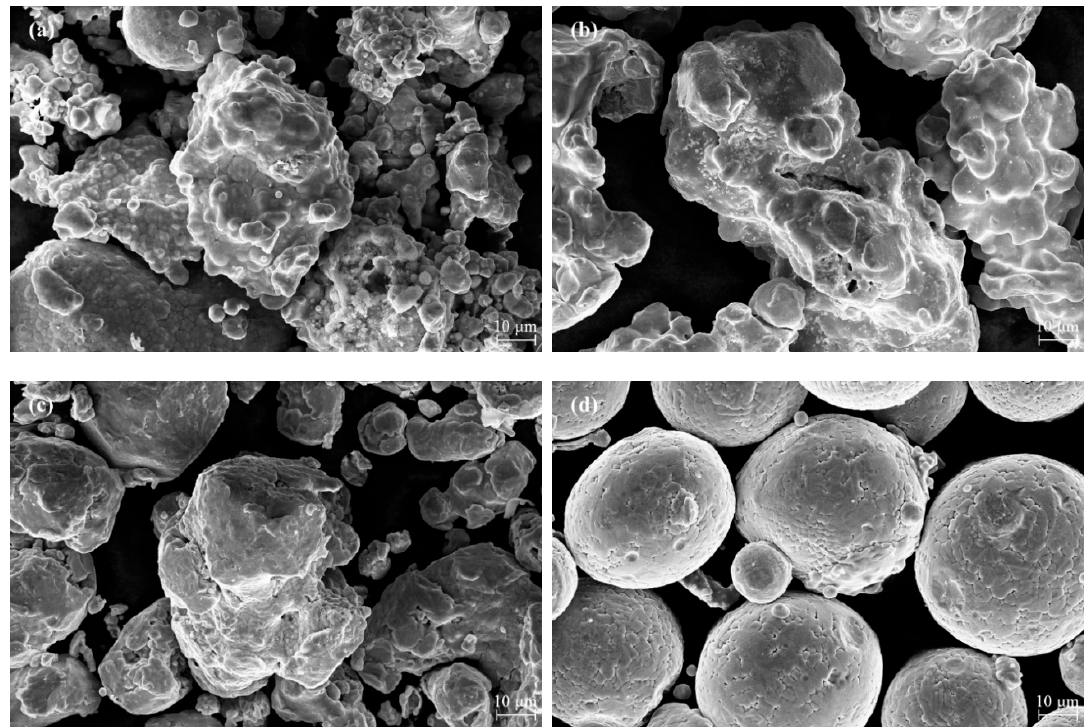
Figure 1. Representative morphology of ( a ) W-2, ( b ) W-4, ( c ) WT-2 and ( d ) G-2 powders.